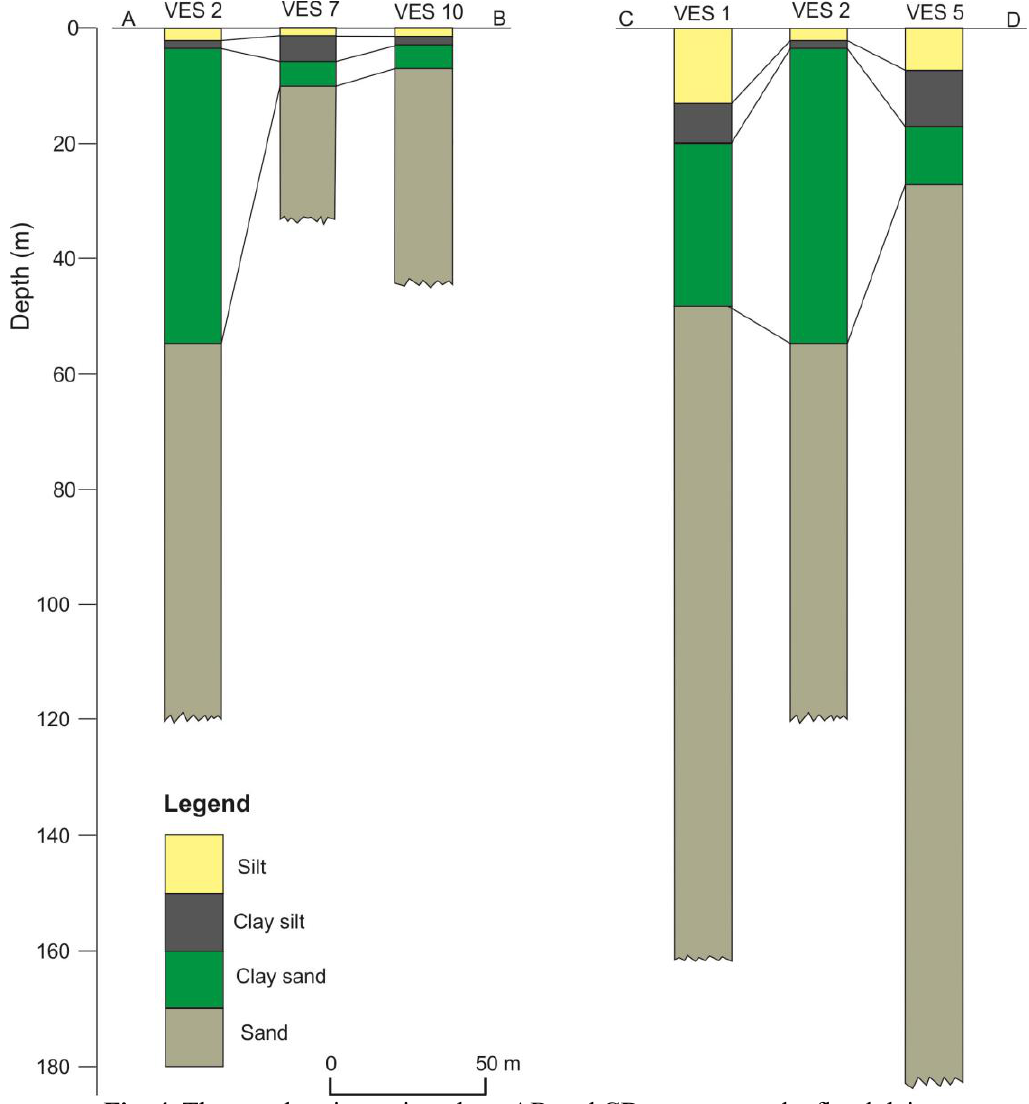
Fig. 4. The geoelectric section along AB and CD transect on the